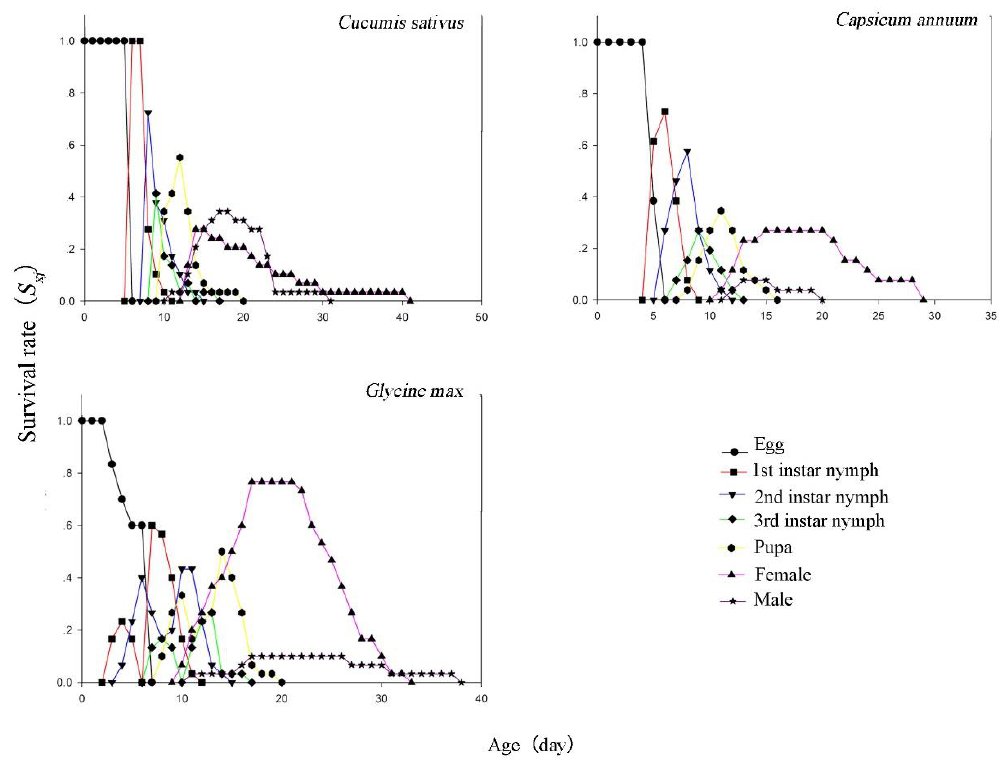
Figure 2. Age stage-specific survival rate ( s xj ) of Thrips flavus on different